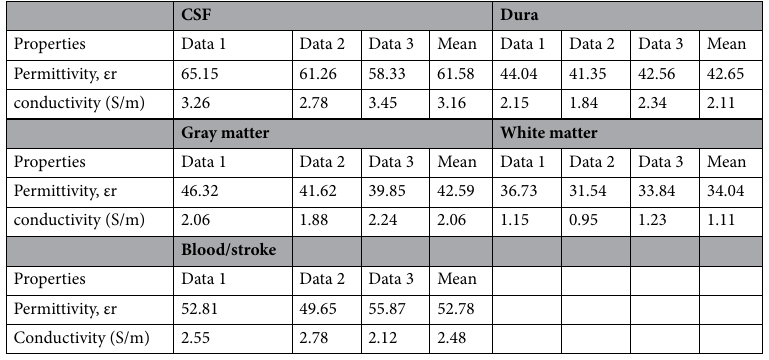
Table 2. Electrical properties of the fabricated head phantom from 1 to 4 GHz.